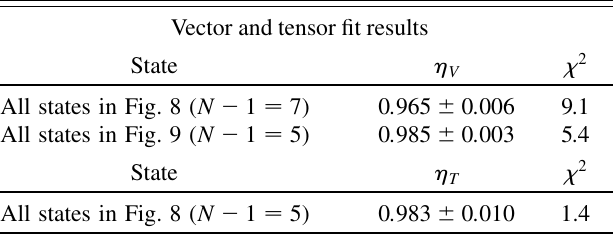
Fit results for Figs. 8 and